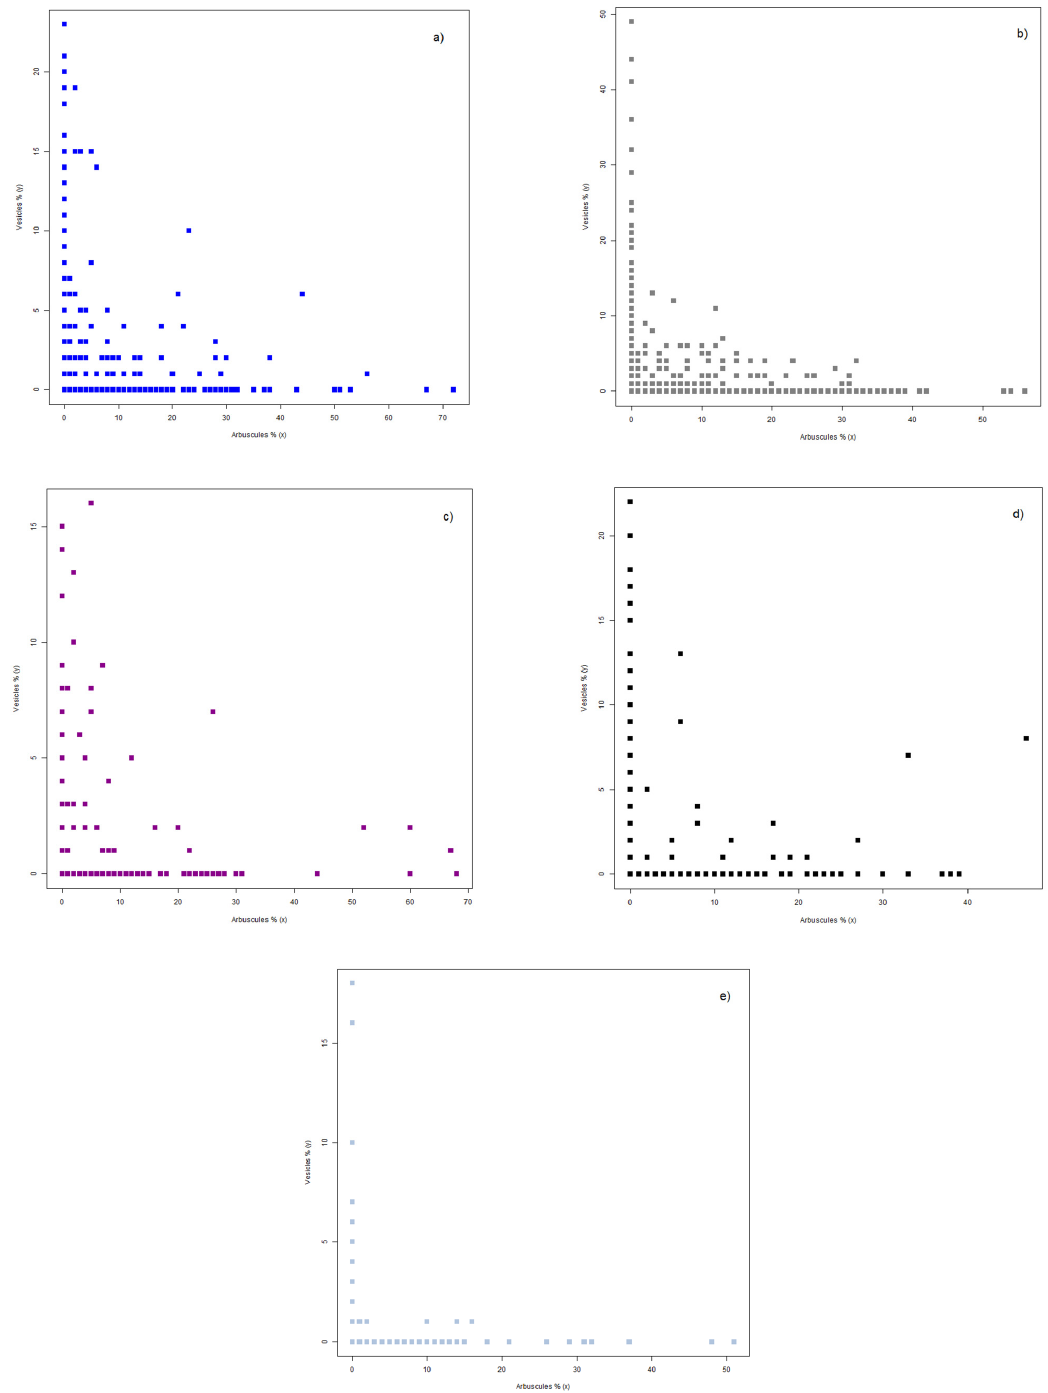
Figure 1. Interdependence between arbuscules and vesicle abundance in A. capillaris due to ap- plied treatments: ( a ) V1 (control variant)—untreated; ( b ) V2—organic (manure) treatment—10 t ha − 1 manure; ( c ) V3—low-mineral organic treatment—10 t ha − 1 manure + 50 N 25 P 2 O 5 25 K 2 O; ( d ) V4—mineral treatment—100 N 50 P 2 O 5 50 K 2 O; and ( e ) V5—high-mineral organic treatment— 10 t ha − 1 manure + 100 N 50 P 2 O 5 50 K 2